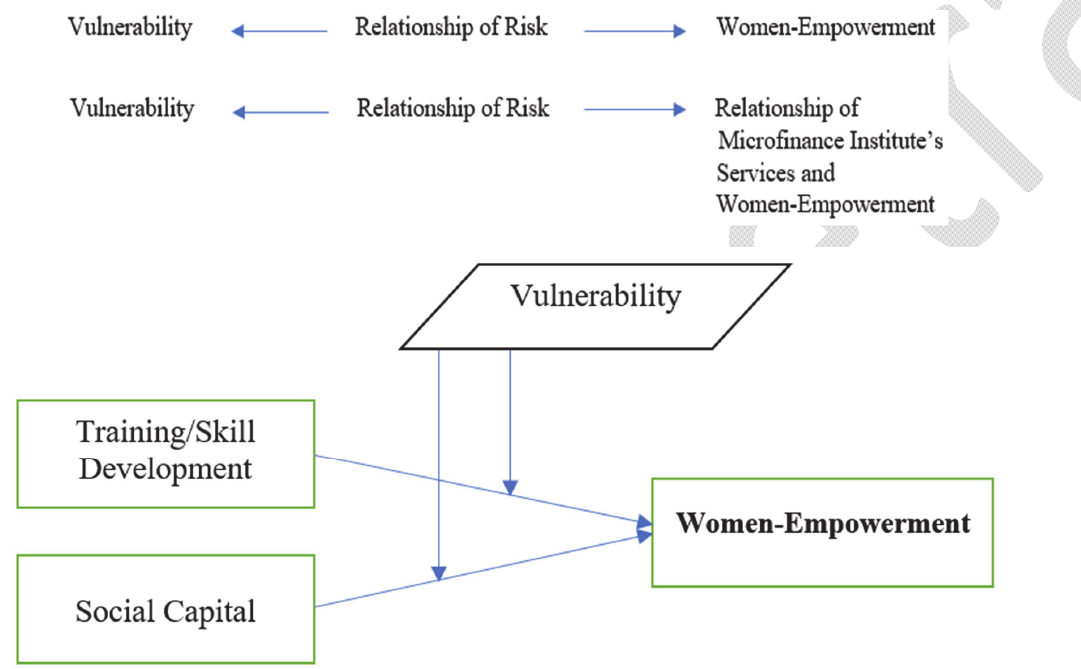
Fig. 1. Theoretical